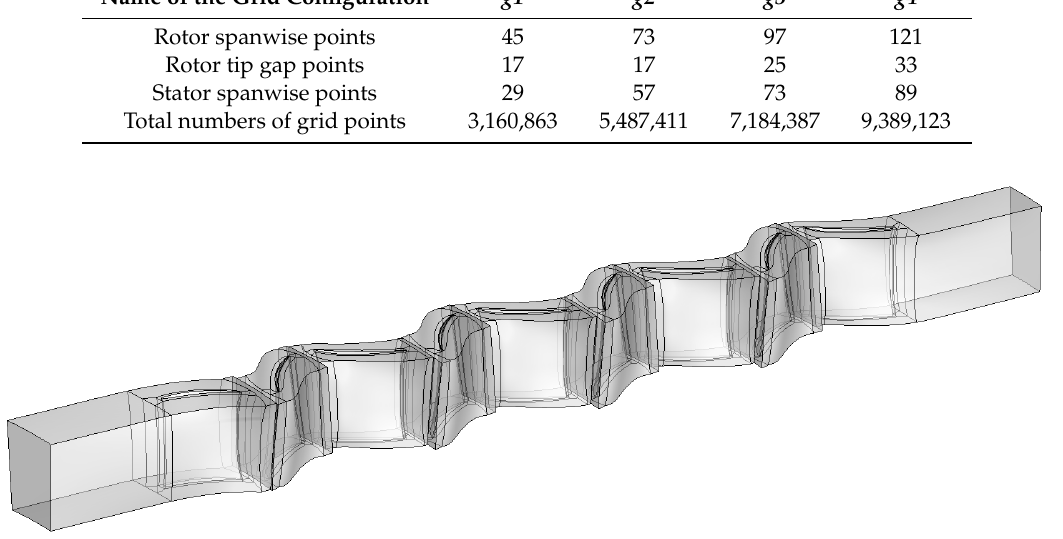
Figure 9. Block distribution for the 4.5 stage compressor.